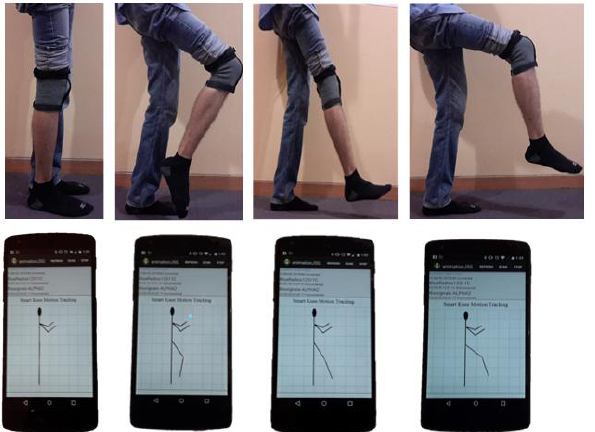
Figure 5 Snapshots of a user’s leg and simultaneous motion tracking by our